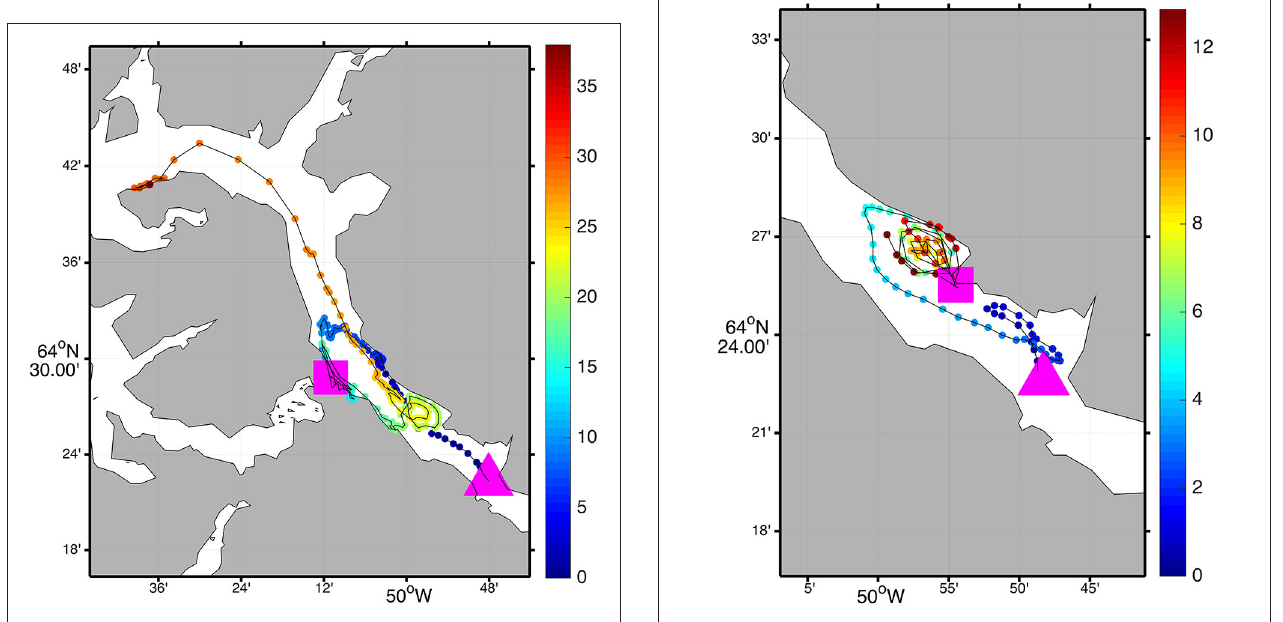
Frontiers in Marine Science |